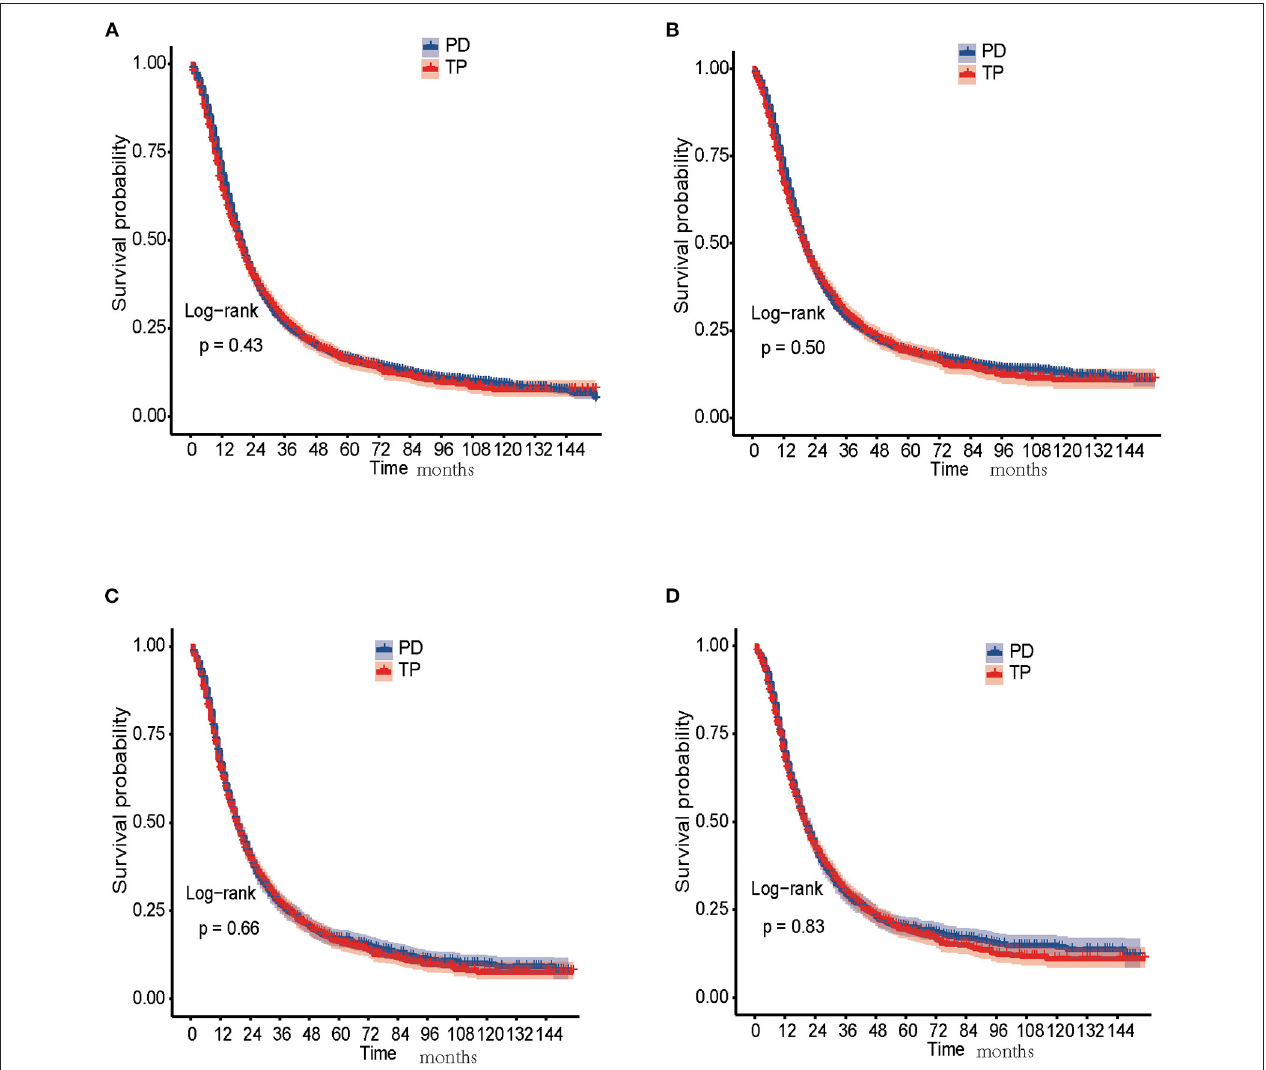
FIGURE 2 | Survival analysis of PDAC patients treated with PD and TP. (A) OS curves of PD and TP groups before PSM; (B) CSS curves of PD and TP groups before PSM; (C) OS curves of PD and TP groups after PSM; (D) CSS curves of PD and TP groups after PSM. CSS, cancer-specific survival ; OS, overall survival; PD, pancreaticoduodenectomy; PDAC, pancreatic ductal adenocarcinoma; PSM, propensity score matching; TP, total pancreatectomy.